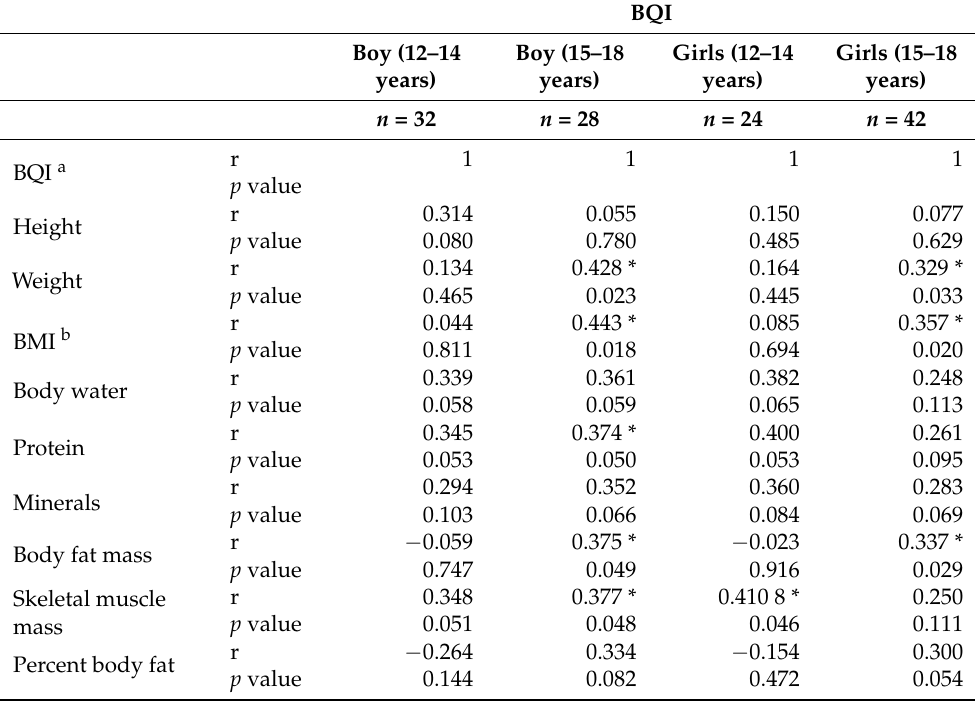
Table A2. Correlations categorized by gender and